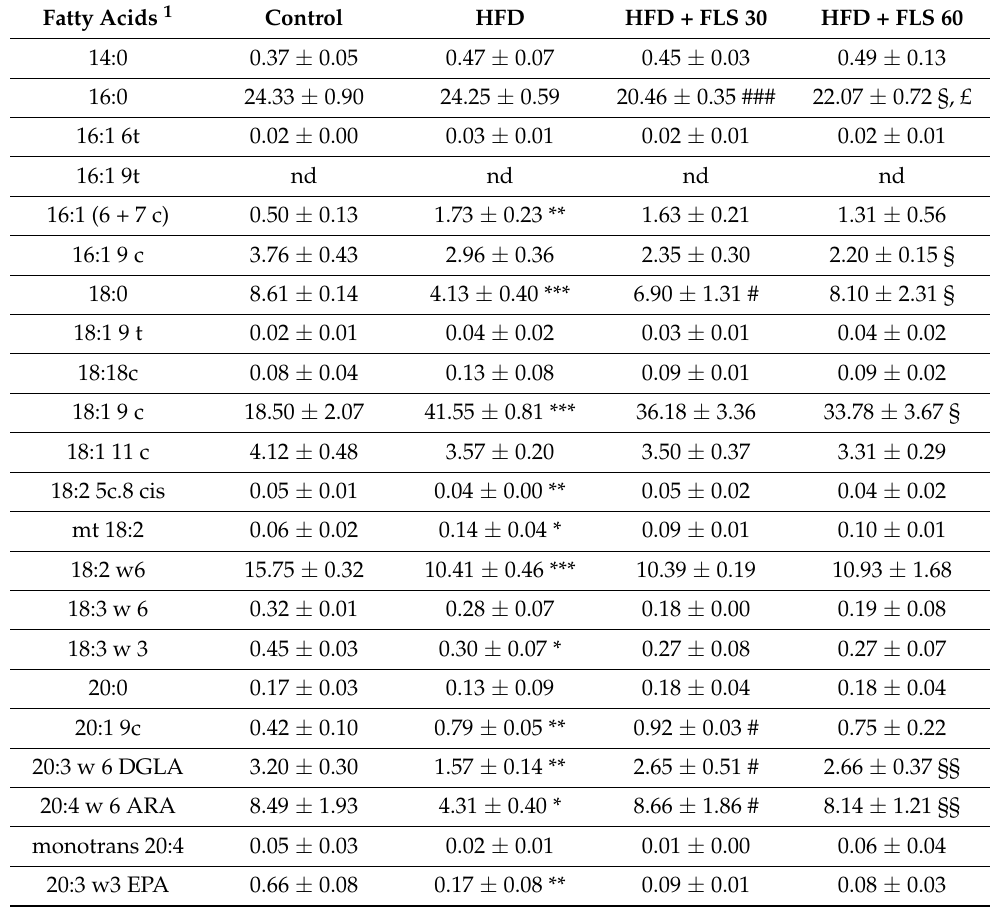
Table 2. Analysis of the total lipids present in the liver tissue of Control mice or mice subjected to HFD diet, treated or not treated with FLS. The type of lipids present in the livers of the animals was determined after extraction of the total lipids and derivation into methyl esters. The statistical analysis carried out using ANOVA showed significant differences, indicated in the table with the symbols specified below. HFD vs. Control: 1 Relative amount * p ≤ 0.047; ** p ≤ 0.0089; *** p ≤